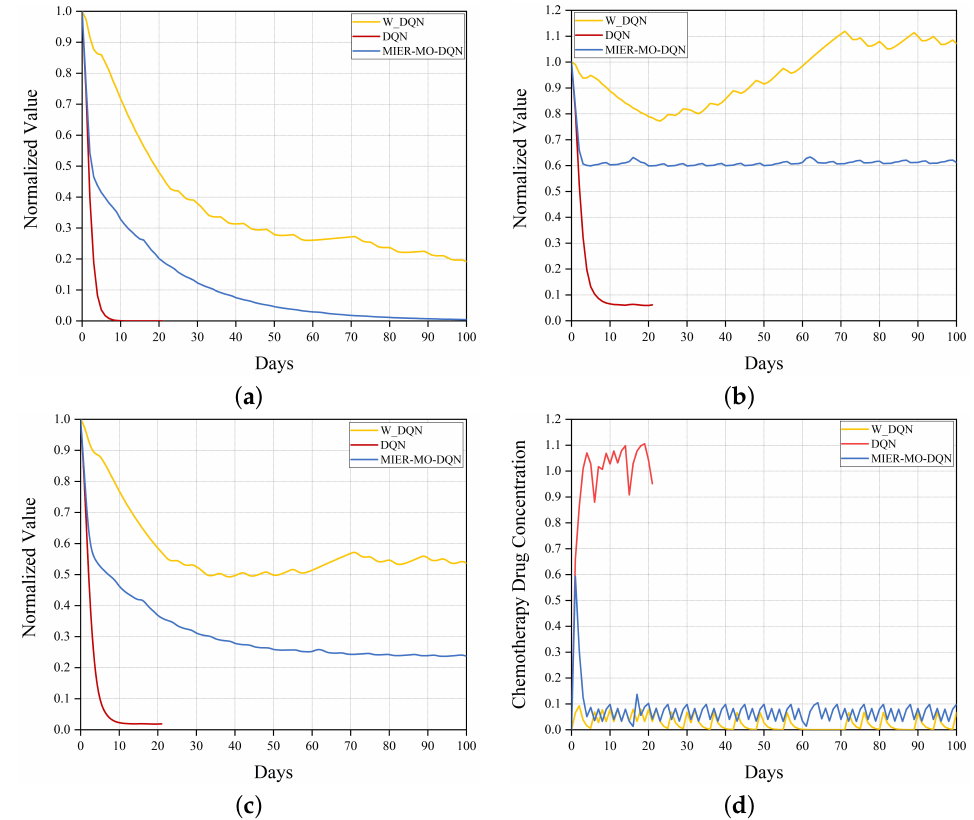
Figure 5. The change of ( a ) tumor cells ( b ) effector-immune cells ( c ) circulating lymphocytes ( d ) drug concentration using different methods in Scenario